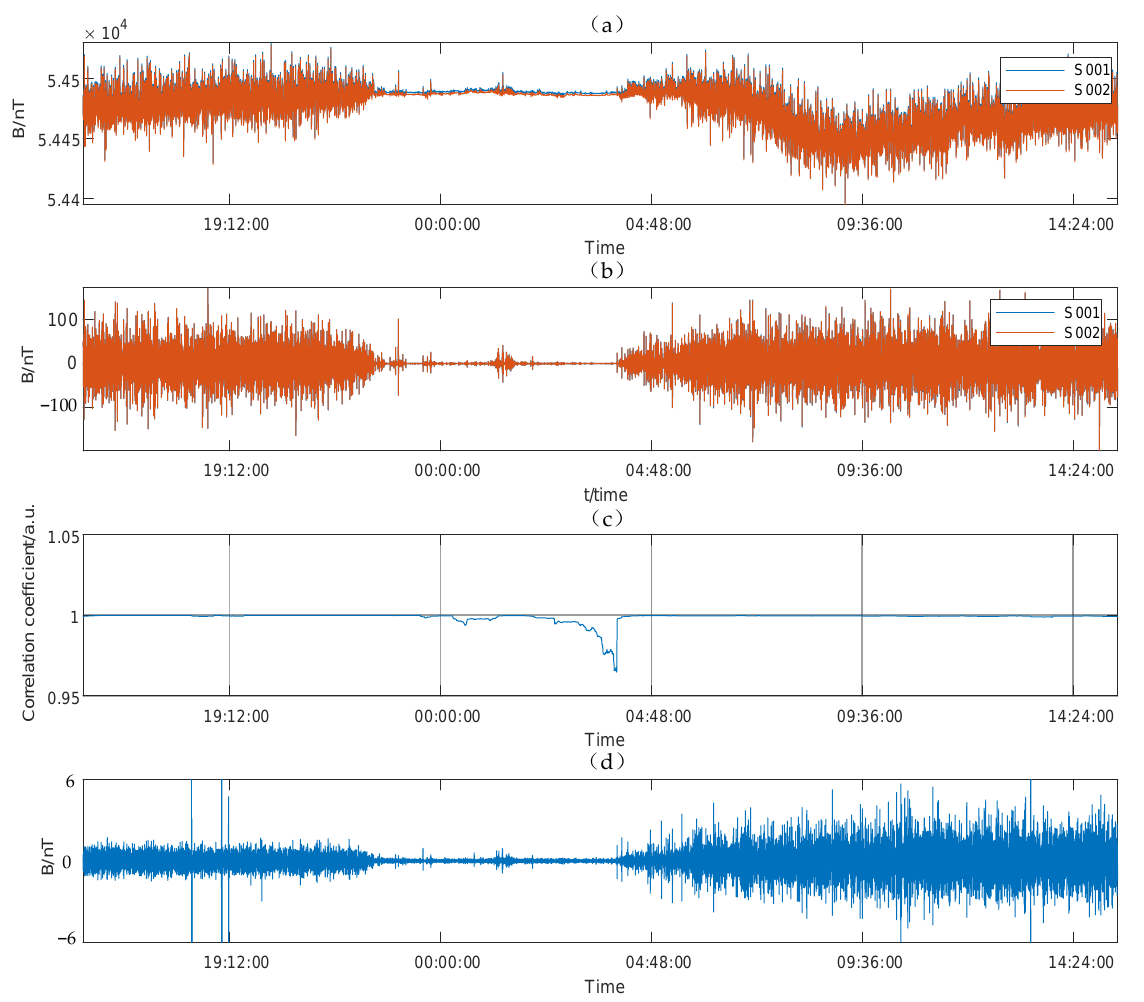
Figure 18. ( a ) 24 h magnetic field value, ( b ) fourth-order difference of the magnetic field, ( c ) correlation coefficient of fourth-order difference of S001 and S002, ( d ) difference value of the fourth-order difference.